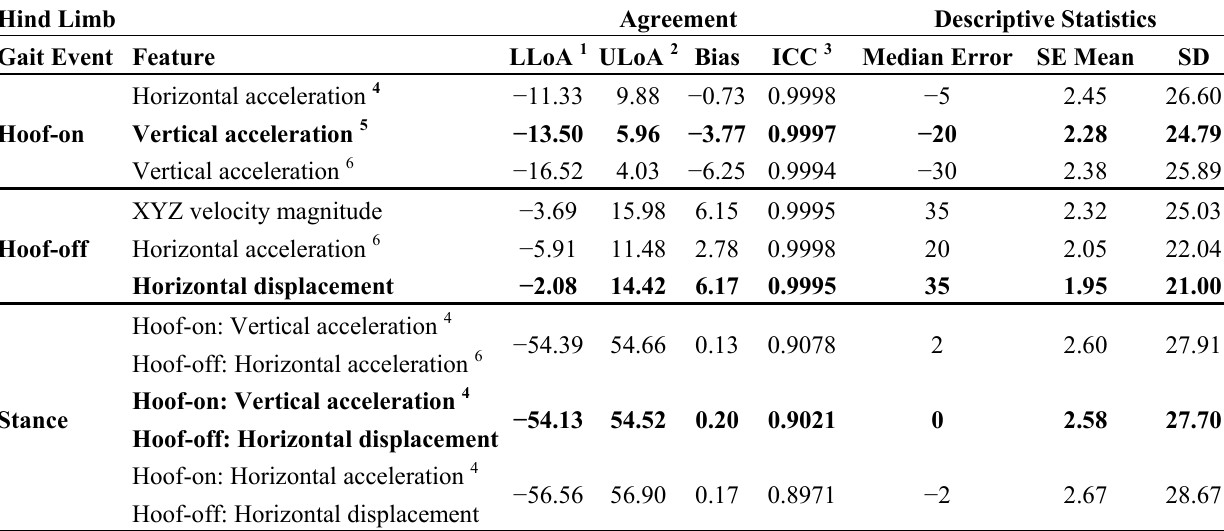
Table 2. Results from agreement analysis and descriptive statistics for hind limb gait events. Displaying the three algorithms with the best (smallest) accuracy and precision, all based on features from DMC A /DMT B mounted IMUs C . All values are in ms. Values in bold have the best (smallest) accuracy and precision. The full table can be accessed online as supplementary